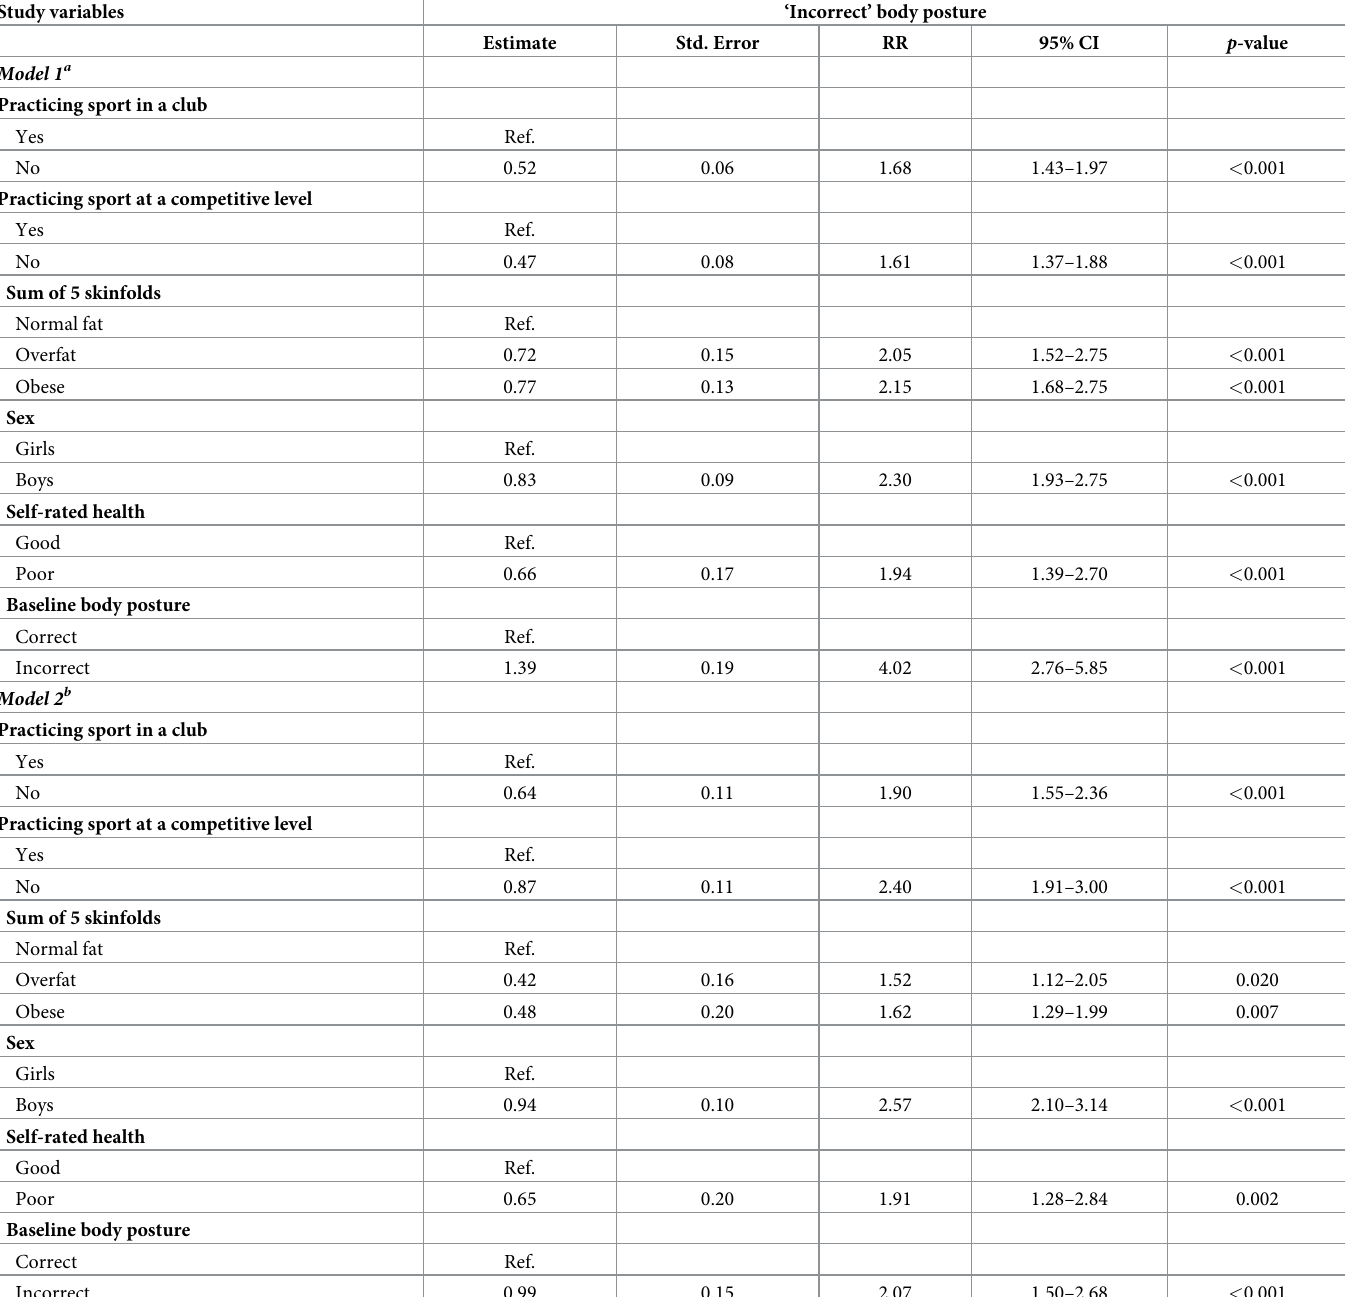
Table 2. Longitudinal linear mixed associations between participation in sport clubs, sport participation at competitive level and sum of 5 skinfolds with ‘incorrect’ body posture in the study